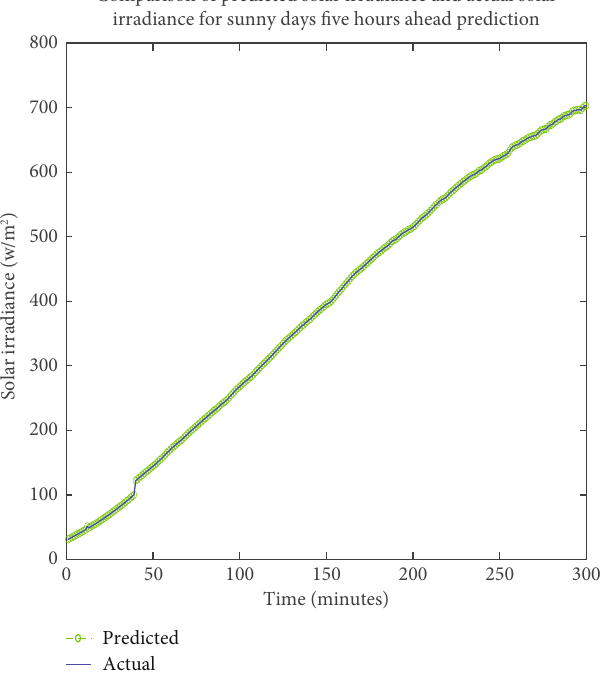
Figure 16: Comparison of predicted solar irradiance and actual solar irradiance for sunny day fi ve-hour-ahead prediction.